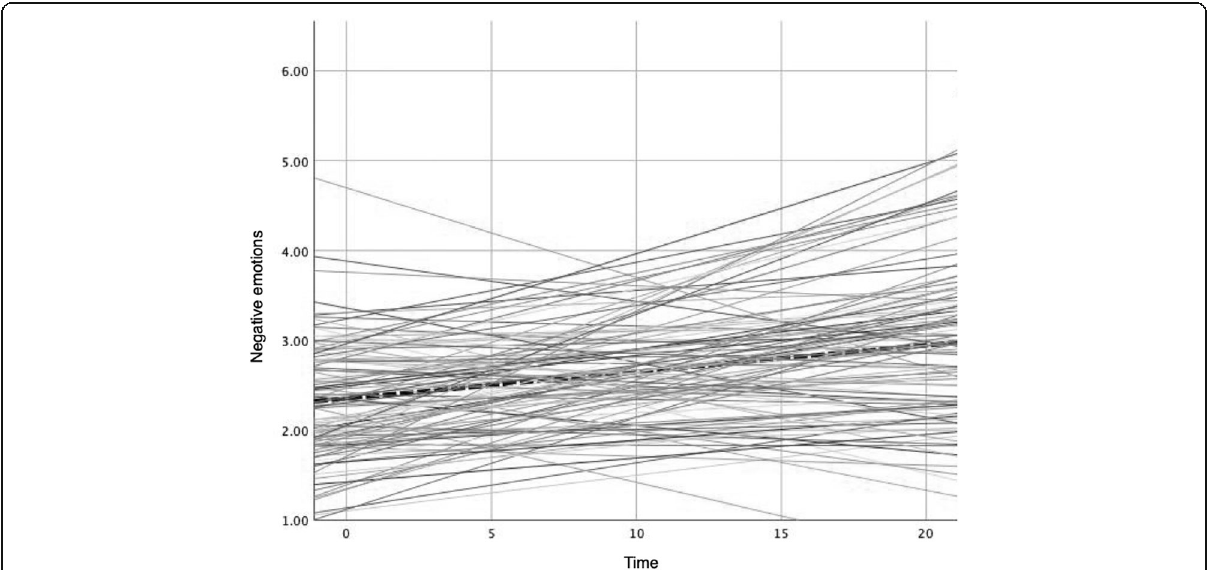
Fig. 2 OLS-Regression for negative emotions on time separated for each student. The dotted line represents the mean regression line